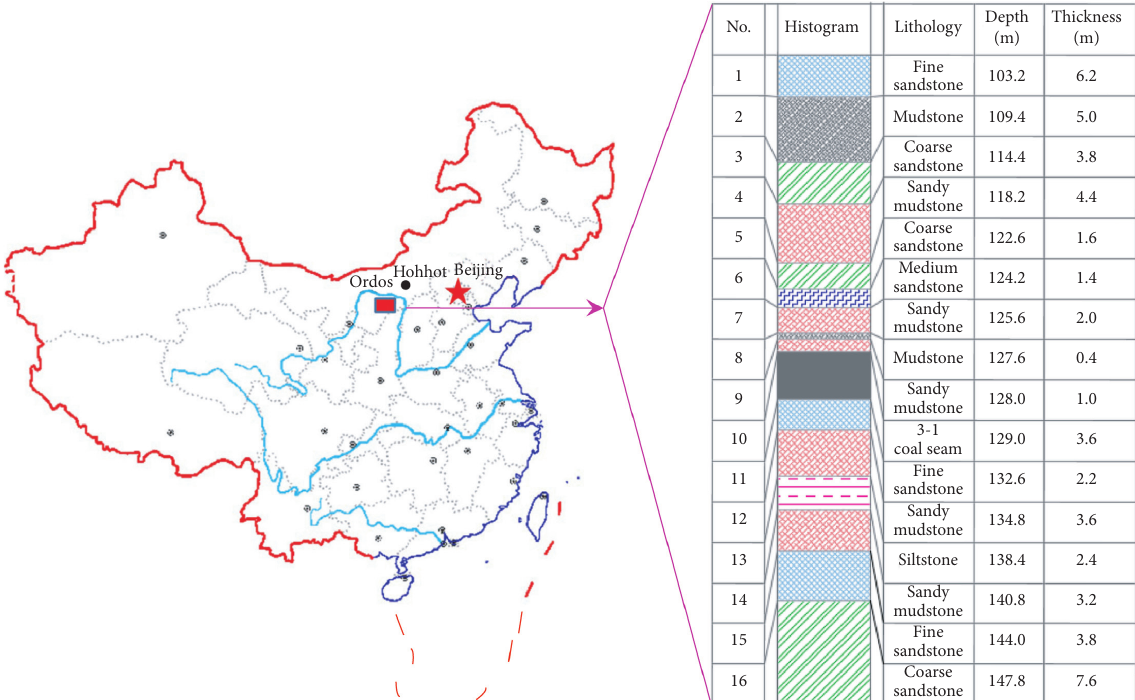
Figure 1: The location of the Wanli No.1 coal mine and the geological column of 31206 open-off